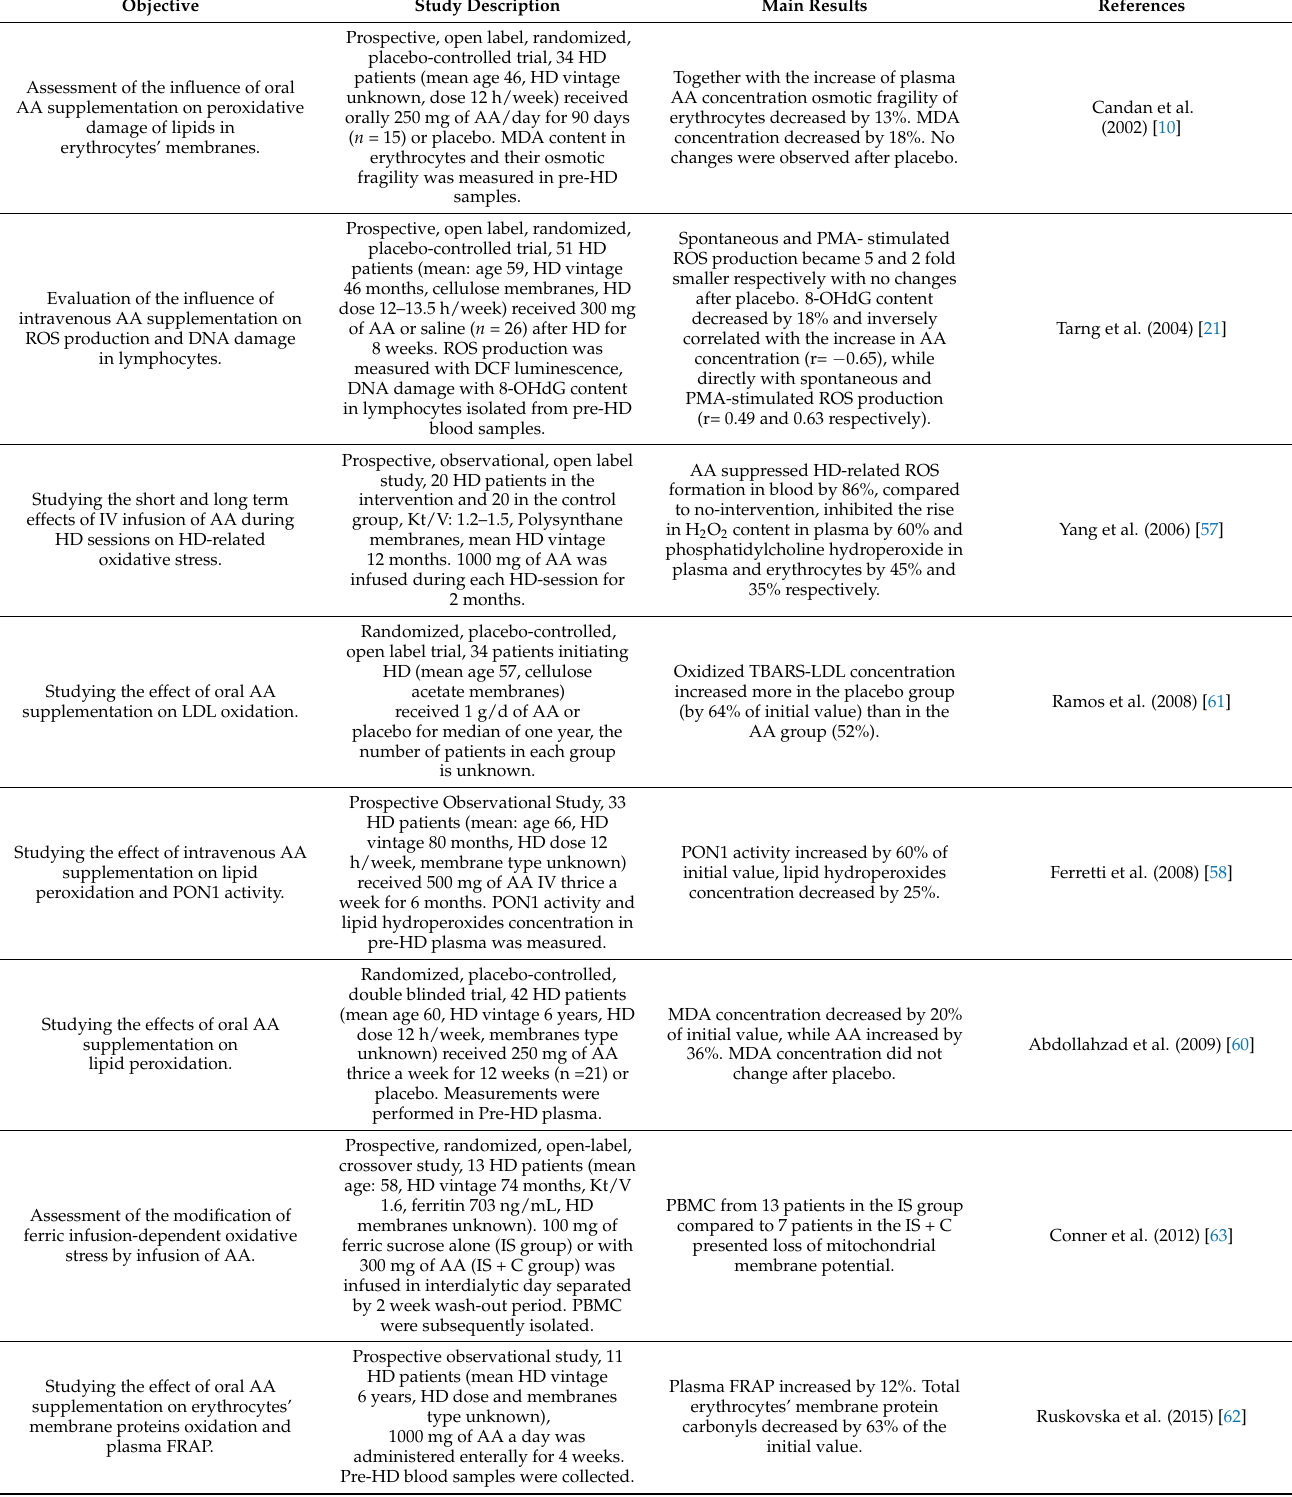
Table 3. The inhibitory effect of ascorbic acid supplementation on oxidative stress in hemodialysis